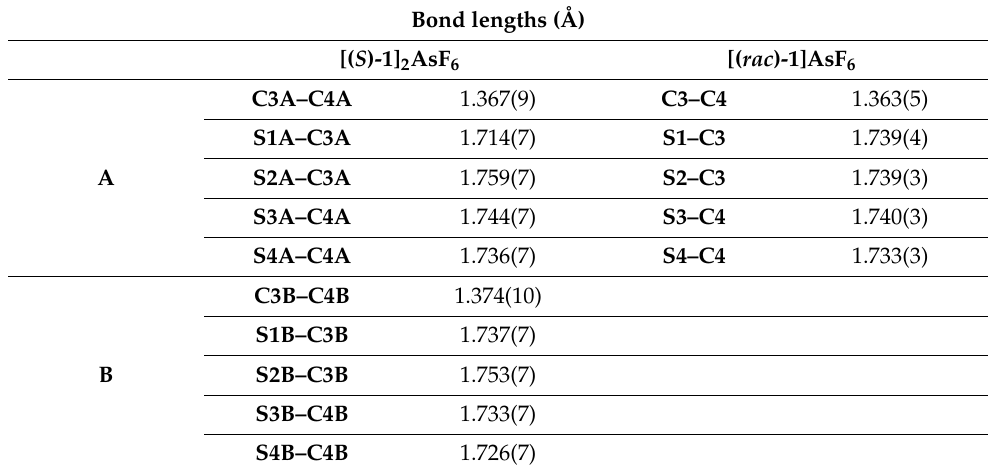
Table 1. Selected C = C and C–S internal bond distances for [( rac )- 1 ] 2 AsF 6 and [( S )- 1 ] 2 AsF 6 .